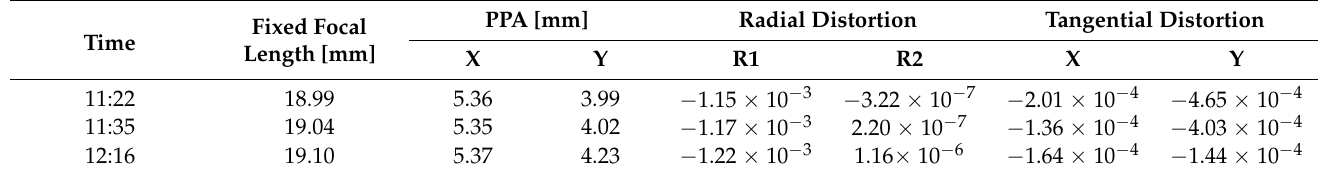
Table A5. Results of geometric calibration for three measurement series for histogram equalization.